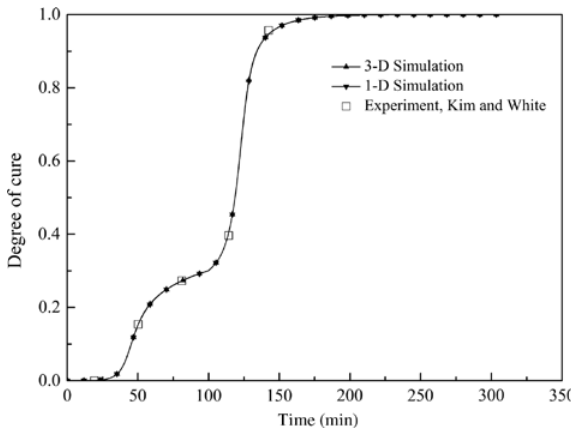
Figure 3: Degree of cure profile in the center of the graphite/epoxy